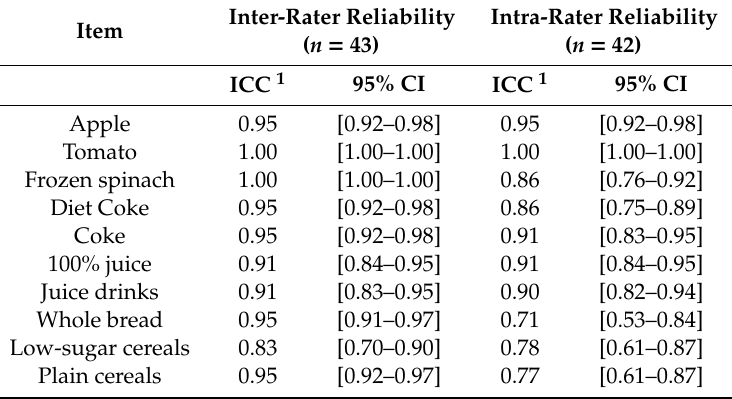
Table 4. Reliability for a ff ordability dimension of the Nutrition Environment Measures Survey in stores for Mediterranean contexts